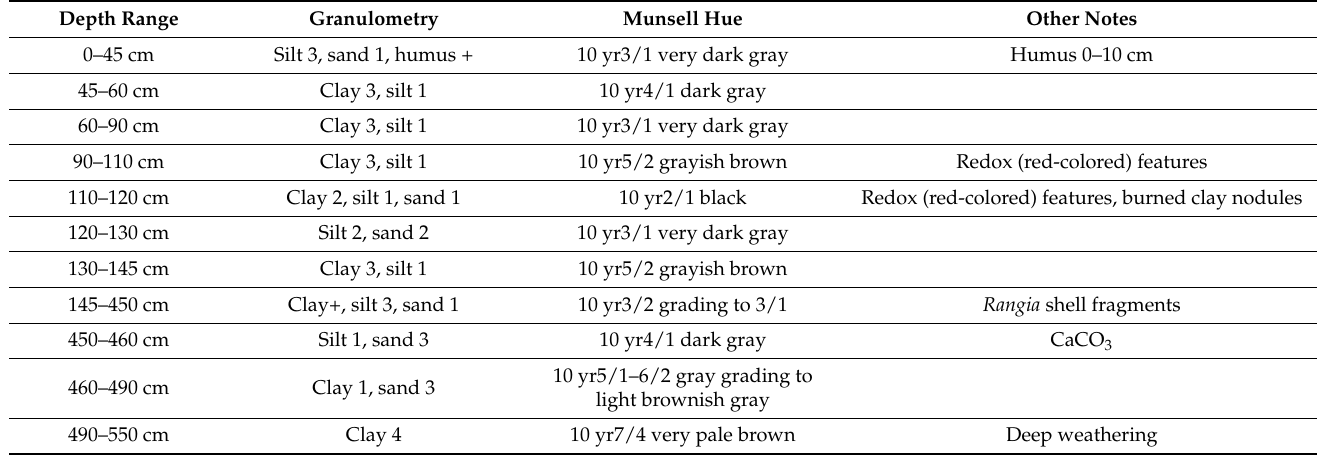
Table 3. Troels-Smith’s description of Buckeye Knoll (BK) sediments [41].